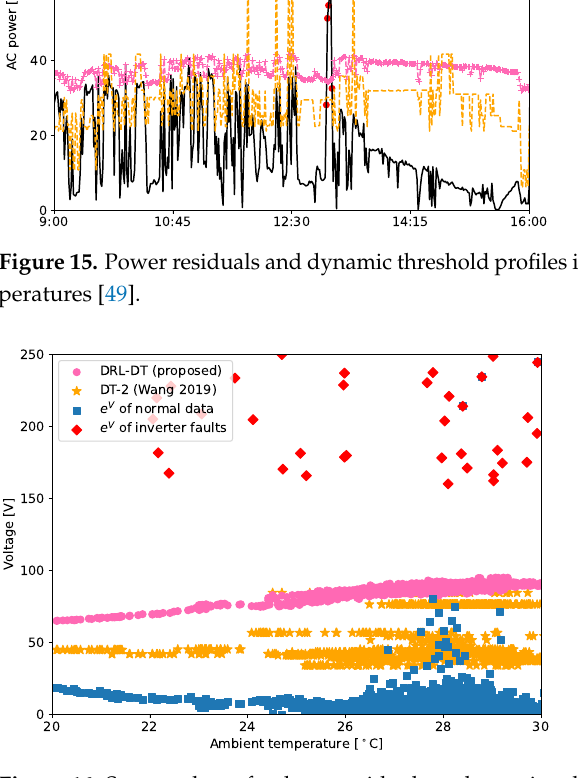
Figure 16. Scatter plots of voltage residuals and associated thresholds by the proposed and conven- tional schemes at high ambient temperatures [49].